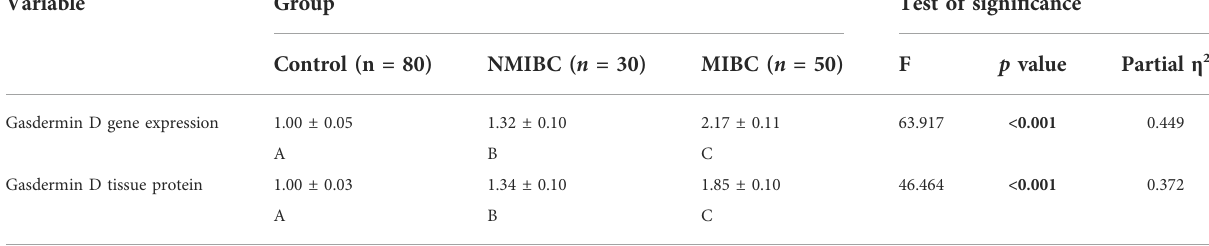
TABLE2GasderminDgeneexpression(byreal-timePCR)andproteinexpression(bywesternblotting)inthecontroltissuesamplesandsamplesfrom cases of the two BC groups: Variable